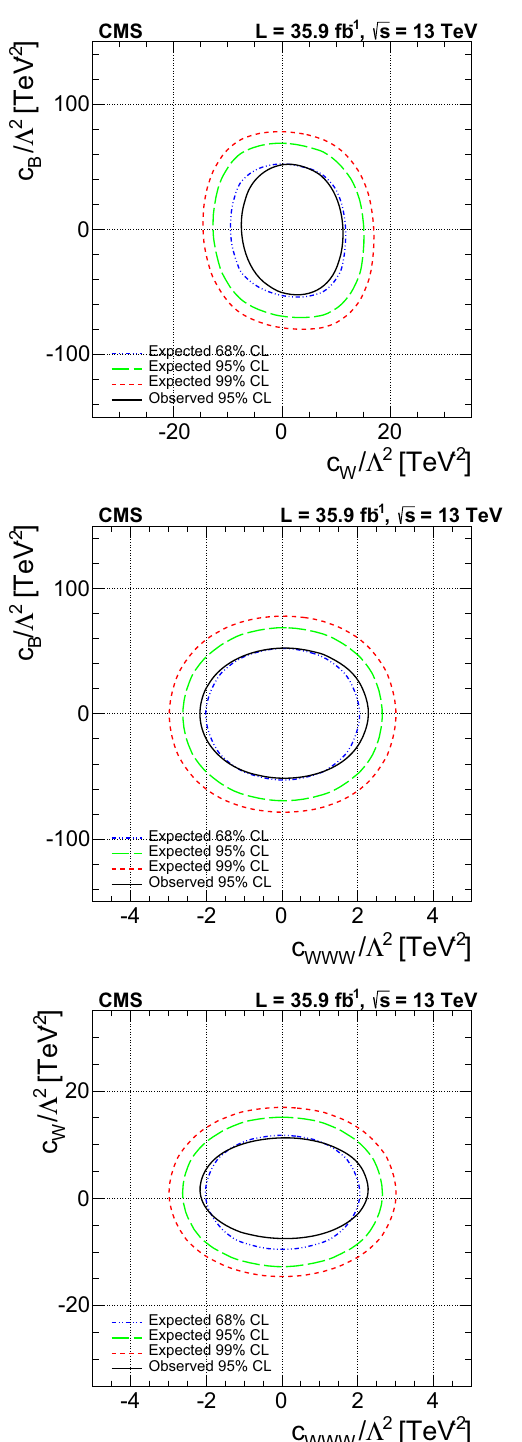
Fig. 14 Expected and observed two-dimensional limits on the ATGC effectiveLagrangian(LEPparametrization)parametersat95%CLfrom the combination of EW Wjj and EW Zjj analyses In all these studies, event distributions are shown with a selection on the output value at BDT > 0 . 95, which allows a signal-enriched region to be selected with a